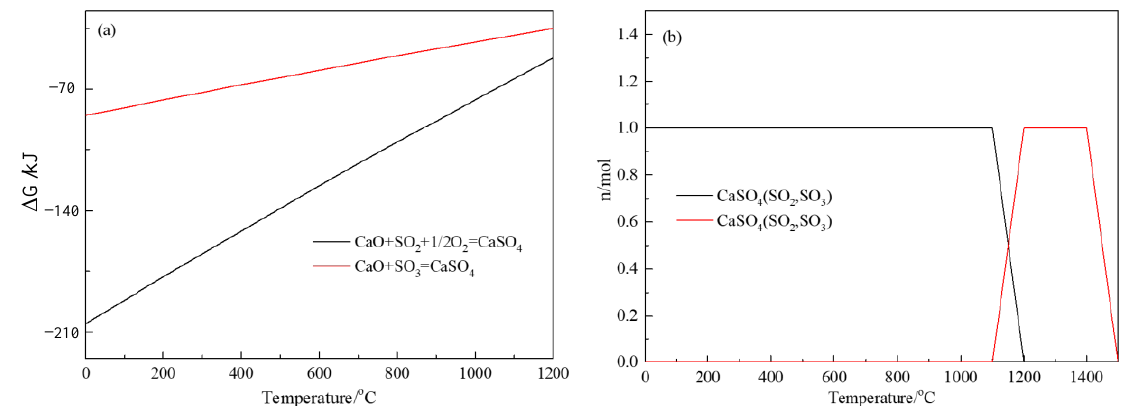
Figure 6. Gibbs free energy ( a ) and equilibrium diagram ( b ) of SO 2 and SO 3 adsorption reaction with calcium oxide.